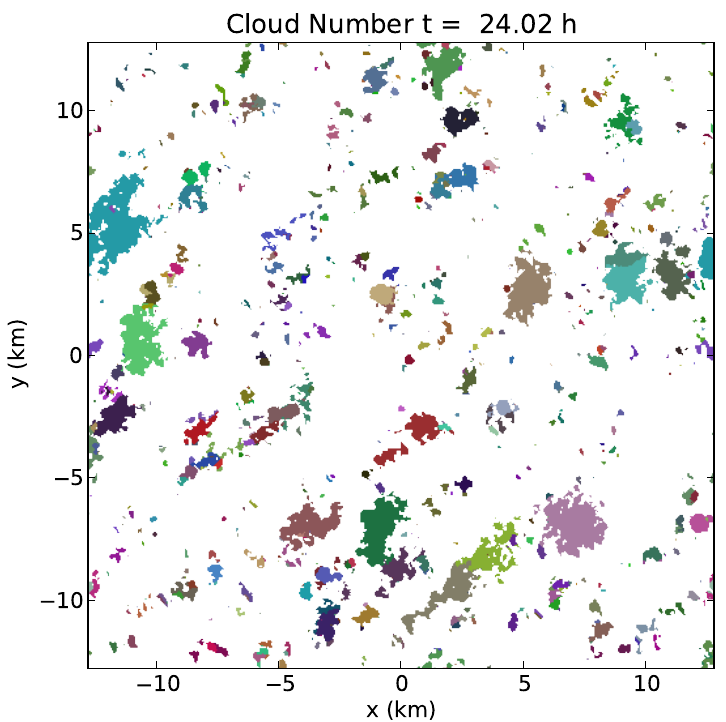
Fig. 4. Projection of the cloud field at t = 24h. Every patch of the same color depicts a single cloud after the application of the splitting algorithm. Colors are assigned randomly; very similar colors may be used occasionally for different